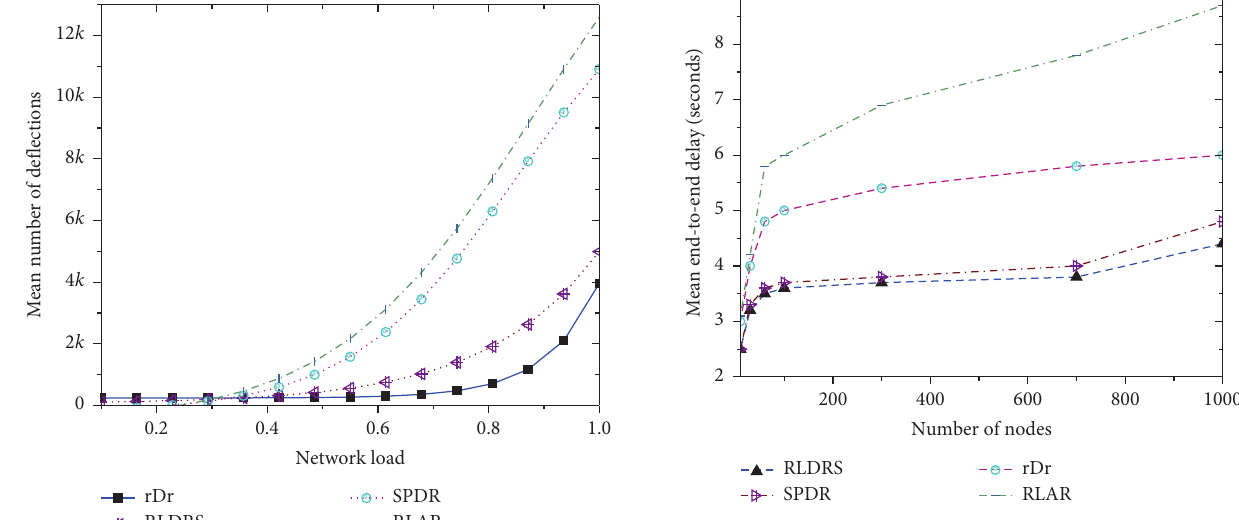
Figure 15: Mean end-to-end delays as function of network